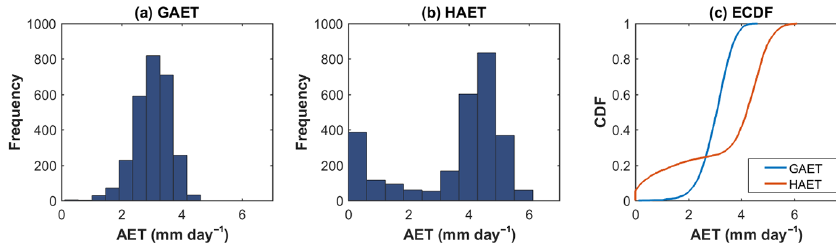
Figure 7. Histogram and ECDF plots of GAET and HAET.